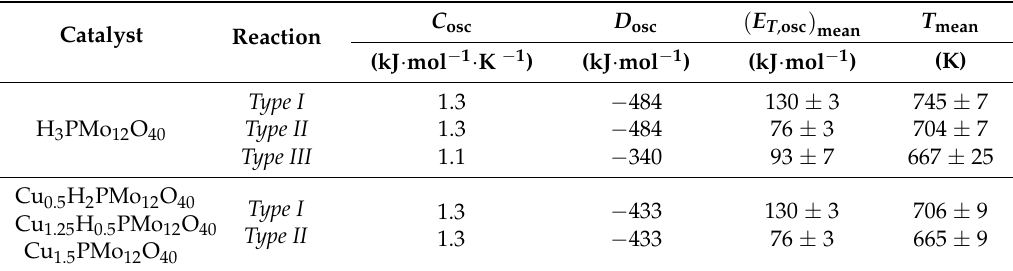
Table 5. Characteristic temperatures, T mean for Types I , II and III calculated from Equation (19) using parameters from the 4 th temperature-programmed runs for the selective oxidation of isobutane to methacrolein over the [PMo 12 O 40 ] 3 −